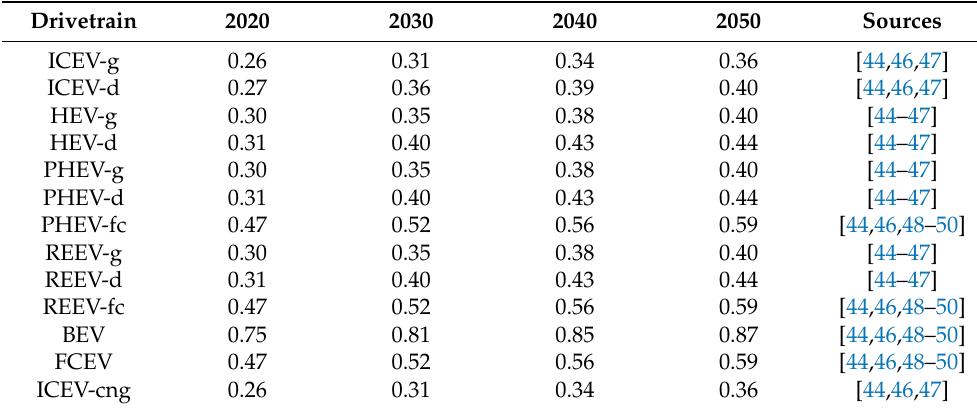
Table 2. Drivetrain efficiencies for LDVs, based on data from different